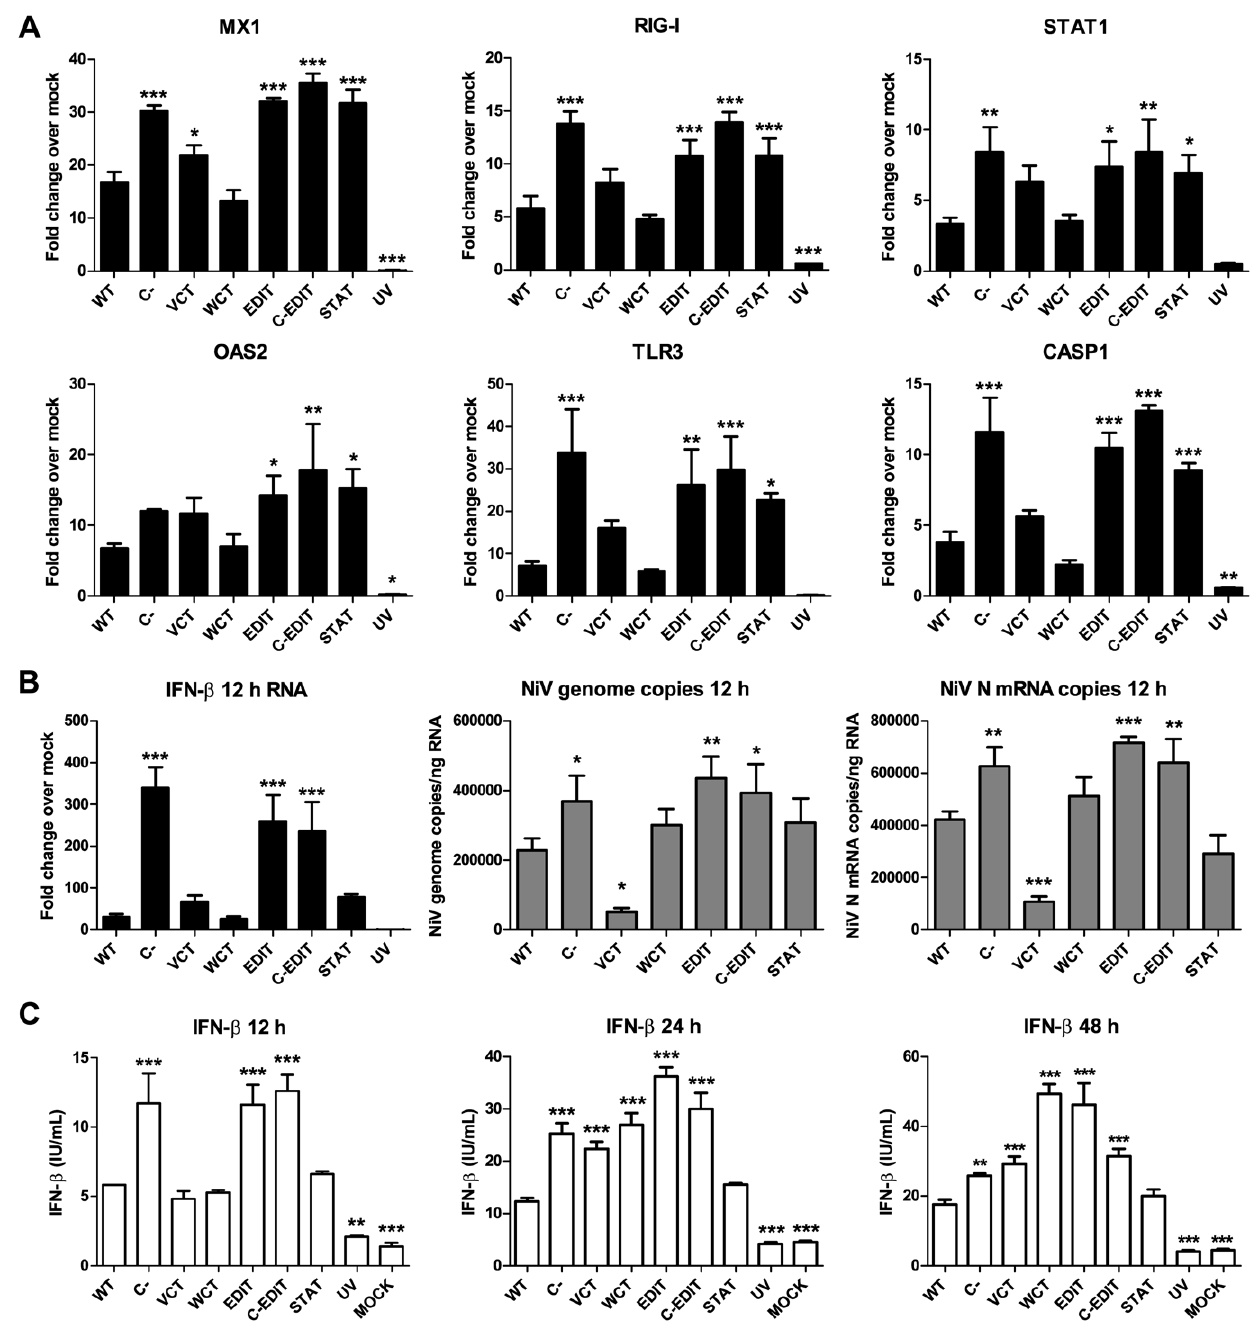
Figure 4. Multiple NiV P gene encoded elements contribute to limit the antiviral response. ( A ) NiV P gene encoded elements limit transcription of antiviral genes. HMVEC-L cells were infected with each recombinant NiV at an MOI=5 and harvested at 12 h PI for total RNA extraction, reverse-transcription, and ensuing real-time PCR array. Levels of mRNA transcription of each antiviral gene indicated over mock were calculated by the delta delta Ct method (see materials and methods). ( B ) Left panel : Levels of IFN- b transcription induced by recombinant NiVs at 12 h PI (MOI=5). Total RNA was extracted and reverse-transcribed as per the above to be used in an antiviral real-time PCR array. Levels of mRNA transcription of IFN- b over mock were calculated by the delta delta Ct method (see materials and methods). Center panel : NiV genome copy numbers from infected HMVEC-L cells at 12 h PI. Total RNA was extracted as mentioned above and reverse-transcribed using a primer against the 3 9 leader sequence to only detect genome copies. Primers against the N gene were utilized to amplify viral genome. Right panel : NiV N gene mRNA copy numbers from infected HMVEC-L cells at 12 h post-infection. Total RNA was extracted as mentioned and reverse-transcribed using an oligo-dT primer to detect NiV N gene mRNA copies. Primers against the N gene were utilized to amplify N gene mRNA. ( C ) Induction of IFN- b secretion by mutant recombinant NiVs. HMVEC-L cells were infected with individual mutant NiVs at MOI=5. At 12 h (left panel), 24 h (center panel), and 48 h (right panel) post-infection, infected cell supernatants were collected and were subject to IFN- b ELISA to measure levels of IFN- b induced by each mutant virus. Error bars for all panels indicate standard deviation of triplicate samples. ANOVA with Dunnett’s multiple comparison test was used to measure the statistical significance of differences in viral replication and transcription, and IFN- b expression for each mutant compared with the WT virus. * p , 0.05; ** p , 0.01; *** p , 0.001. doi:10.1371/journal.pone.0047790.g004 PLOS ONE |